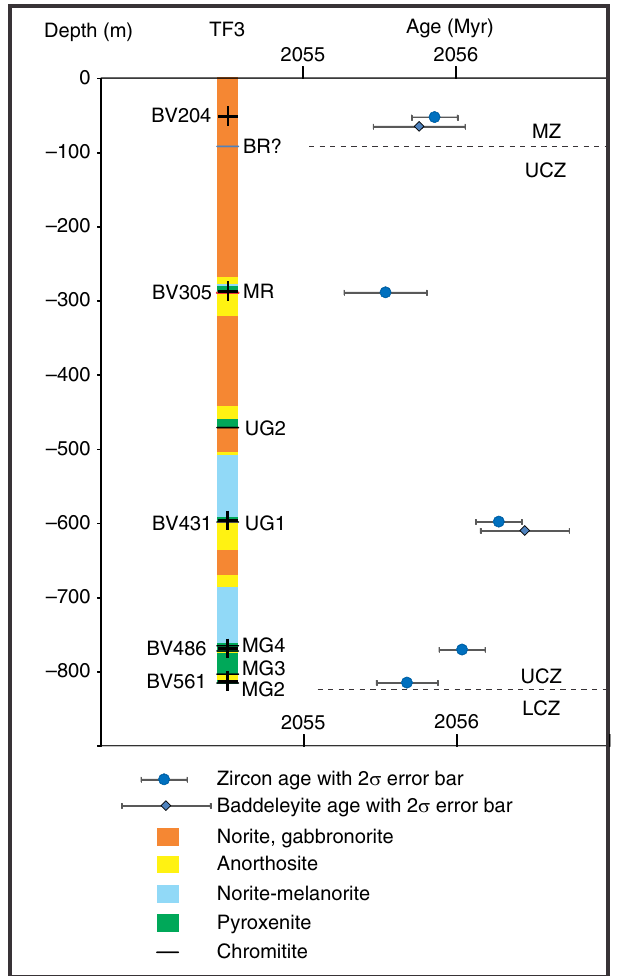
Figure 2 | Schematic chronostratigraphy of lithologies intersected by DDH TF3 in the Western Lobe. The colours along the borehole are a simplified representation of the more detailed lithological log in Supplementary Data 1. Weighted mean zircon 207 Pb/ 206 Pb ages determined in this study are shown (BR is Bastard Reef; MR is Merensky Reef; UG2, UG1, MG2-4 are chromitites as described in the main text; LCZ is Lower Critical Zone; UCZ is Upper Critical Zone; MZ is Main Zone). Crosses in the section refer to locations of dated samples. Error bars show 2 s confidence